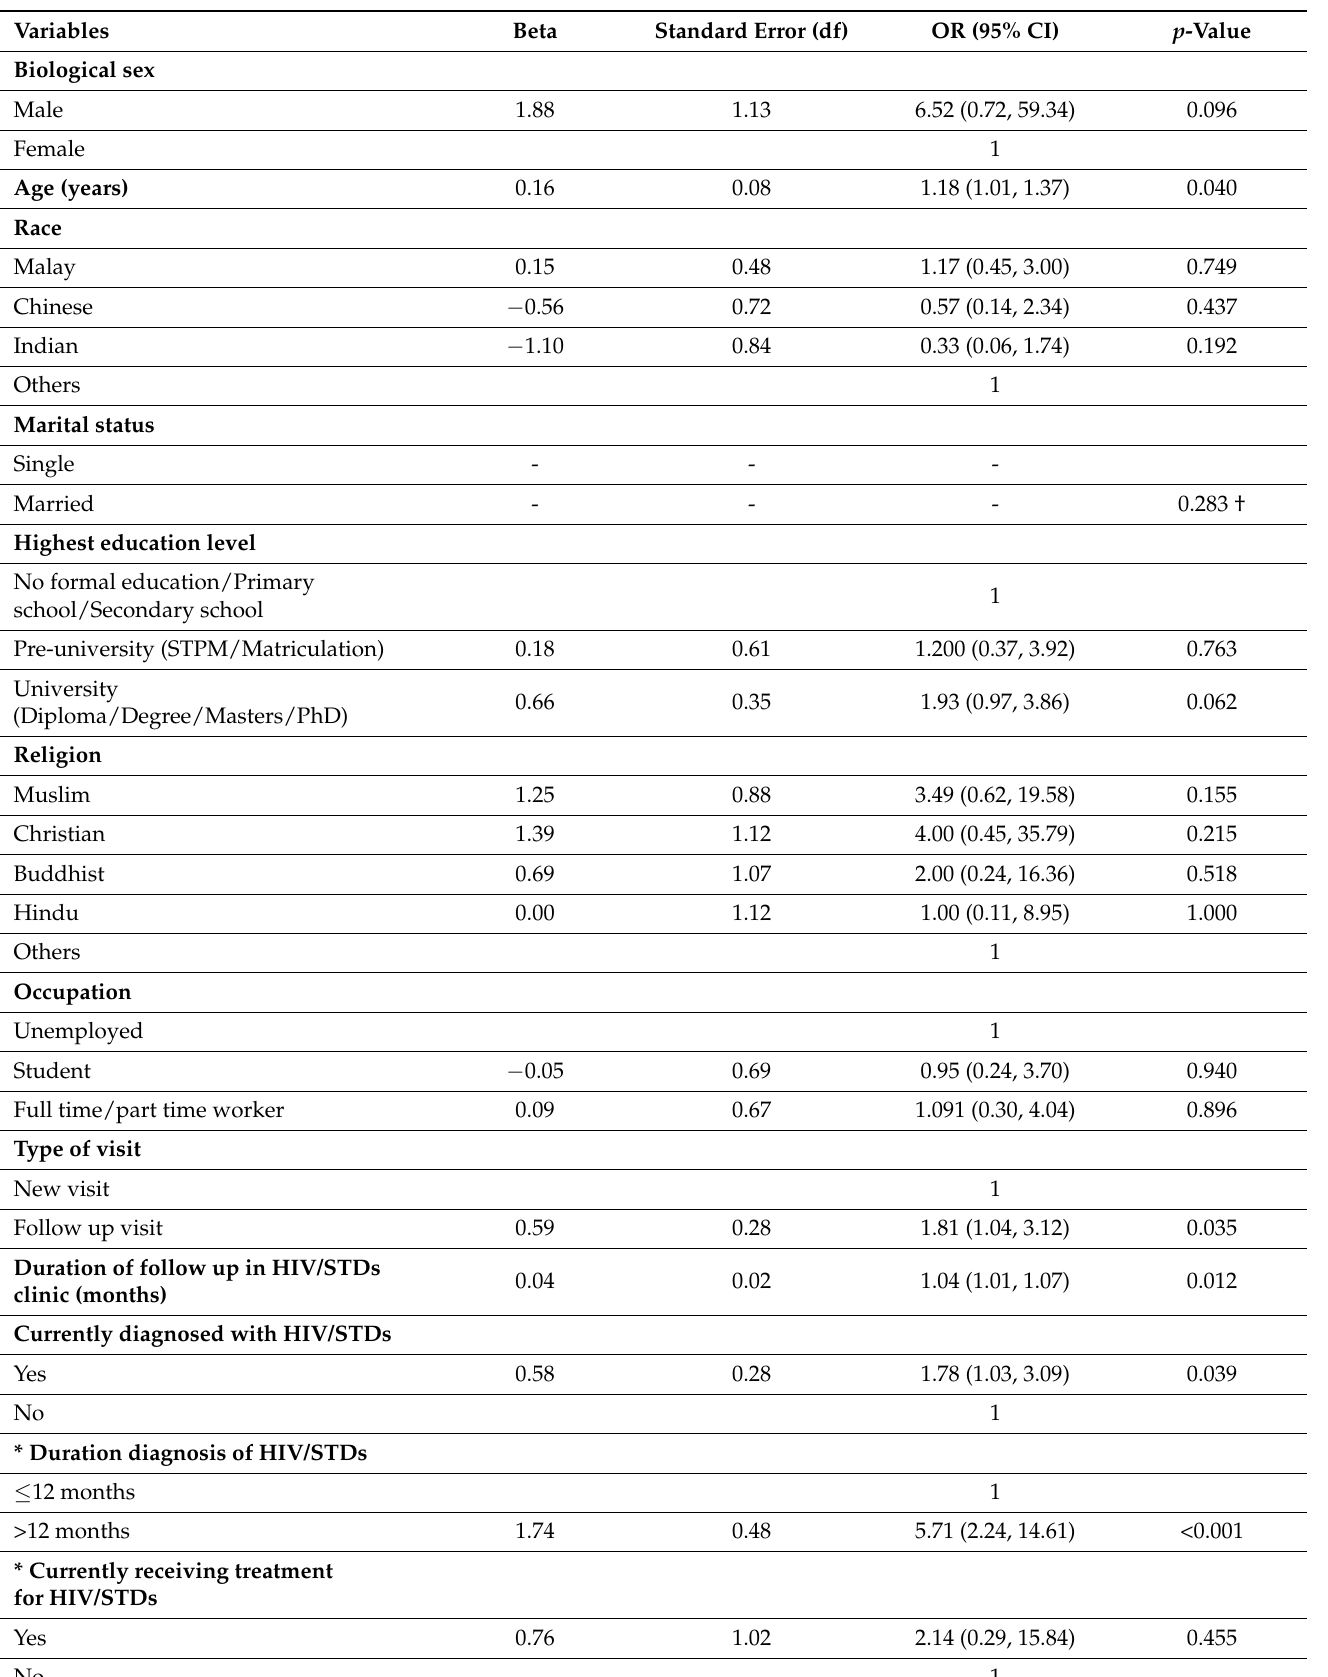
Table 4. Simple logistic regression on factors associated with good condom